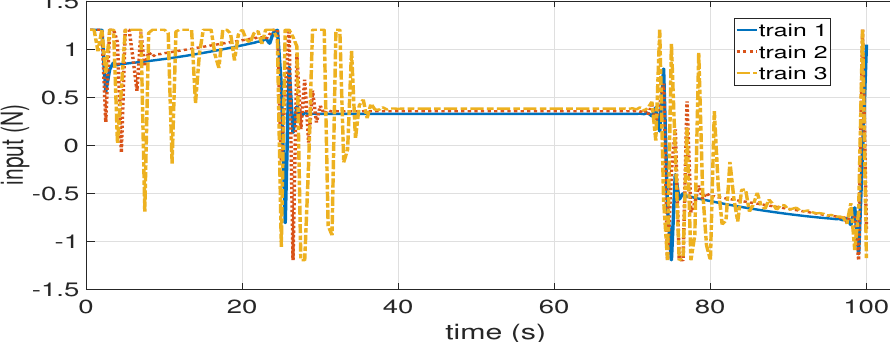
Figure 12. The control input of trains in VC driving on inter-station with AMPCVS